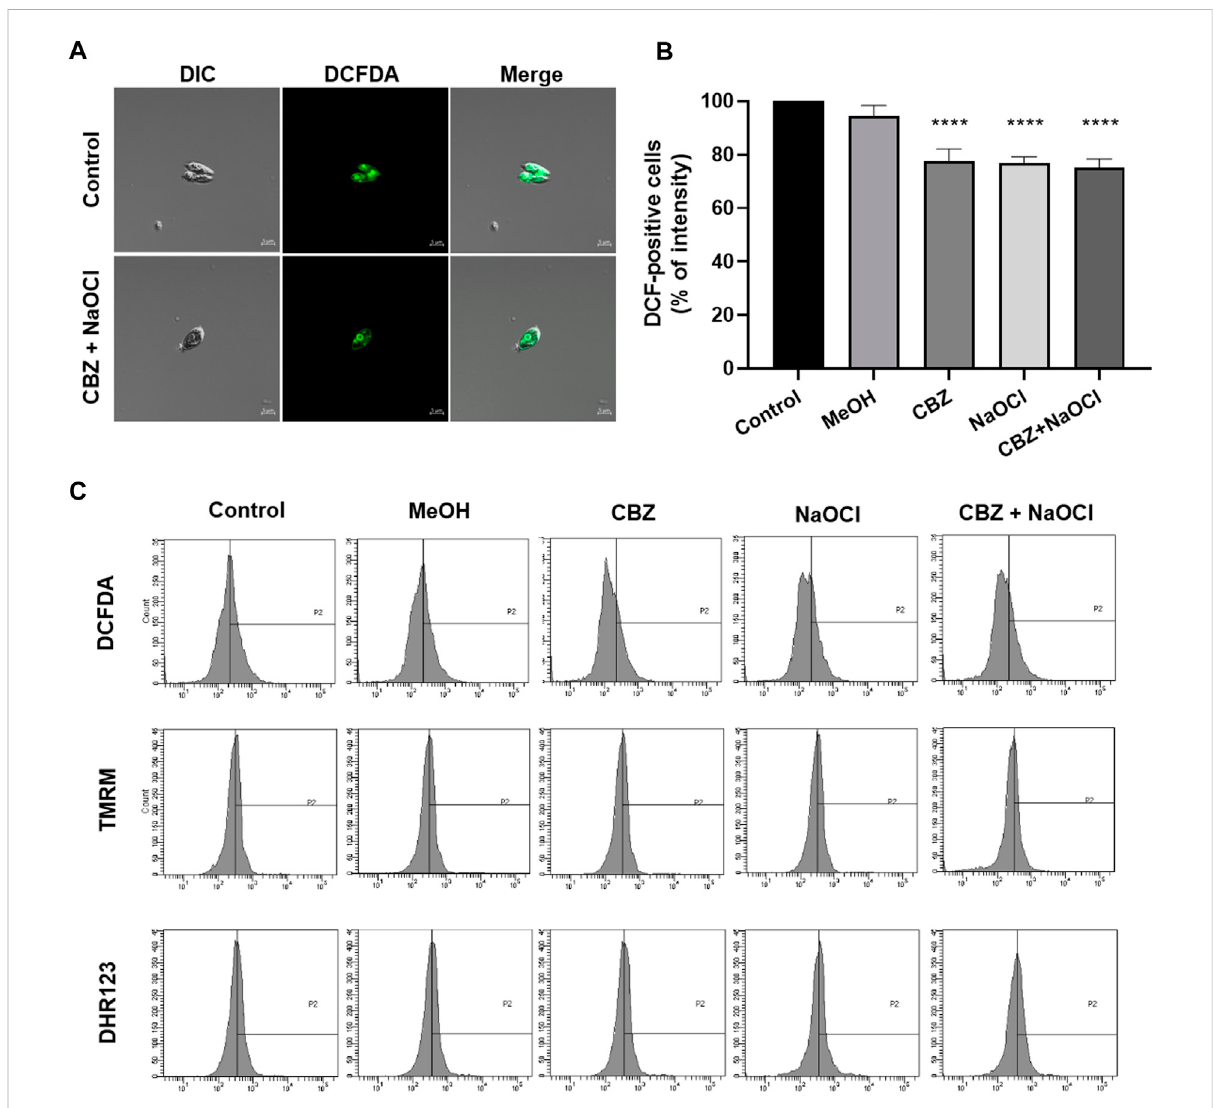
FIGURE 4 Determination of ROS content in T. obliquus KNUA061 after exposure to CBZ and NaOCl. (A) Confocal microscopy images of H2DCFDA- stained T. obliquus KNUA061; scale bars are shown in each image. (B,C) Relative intensity was measured using FACS after H2DCFDA, TMRM, and DHR123 staining. (**** p -value <